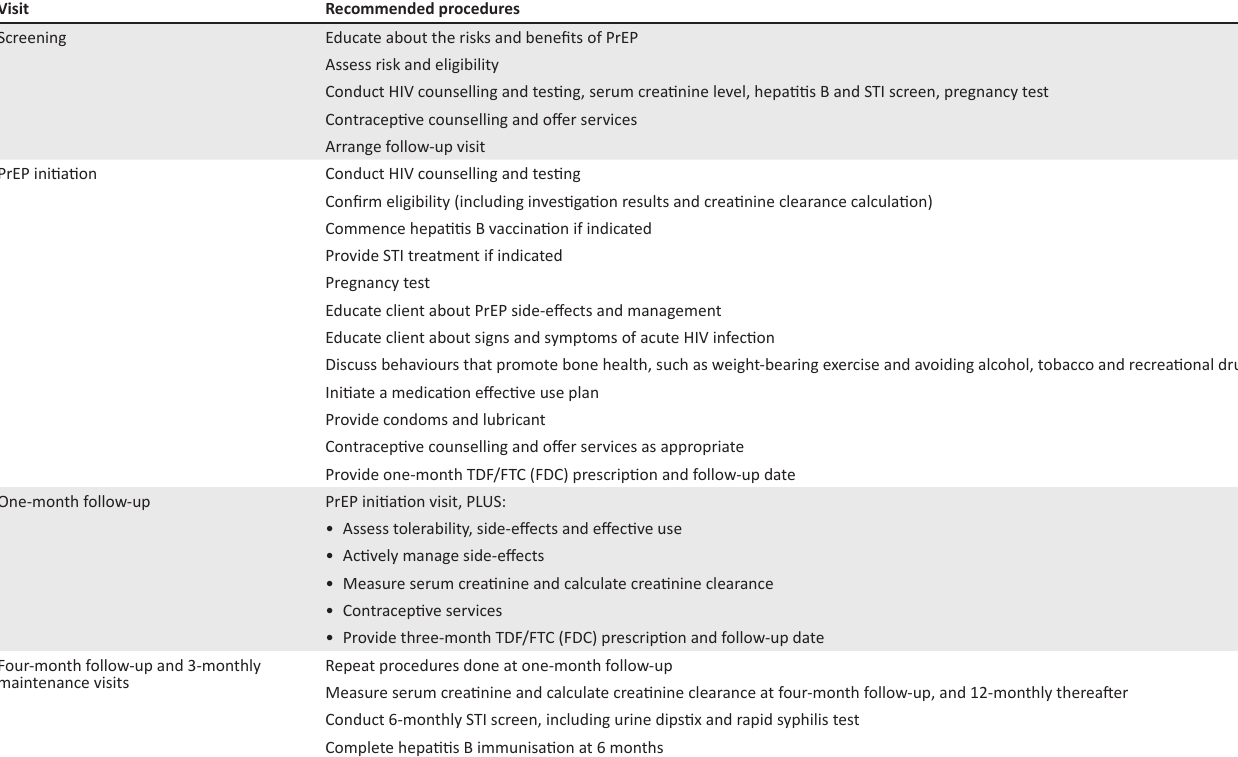
TABLE 2: Summary of pre-exposure prophylaxis visits and procedures. Visit Recommended procedures